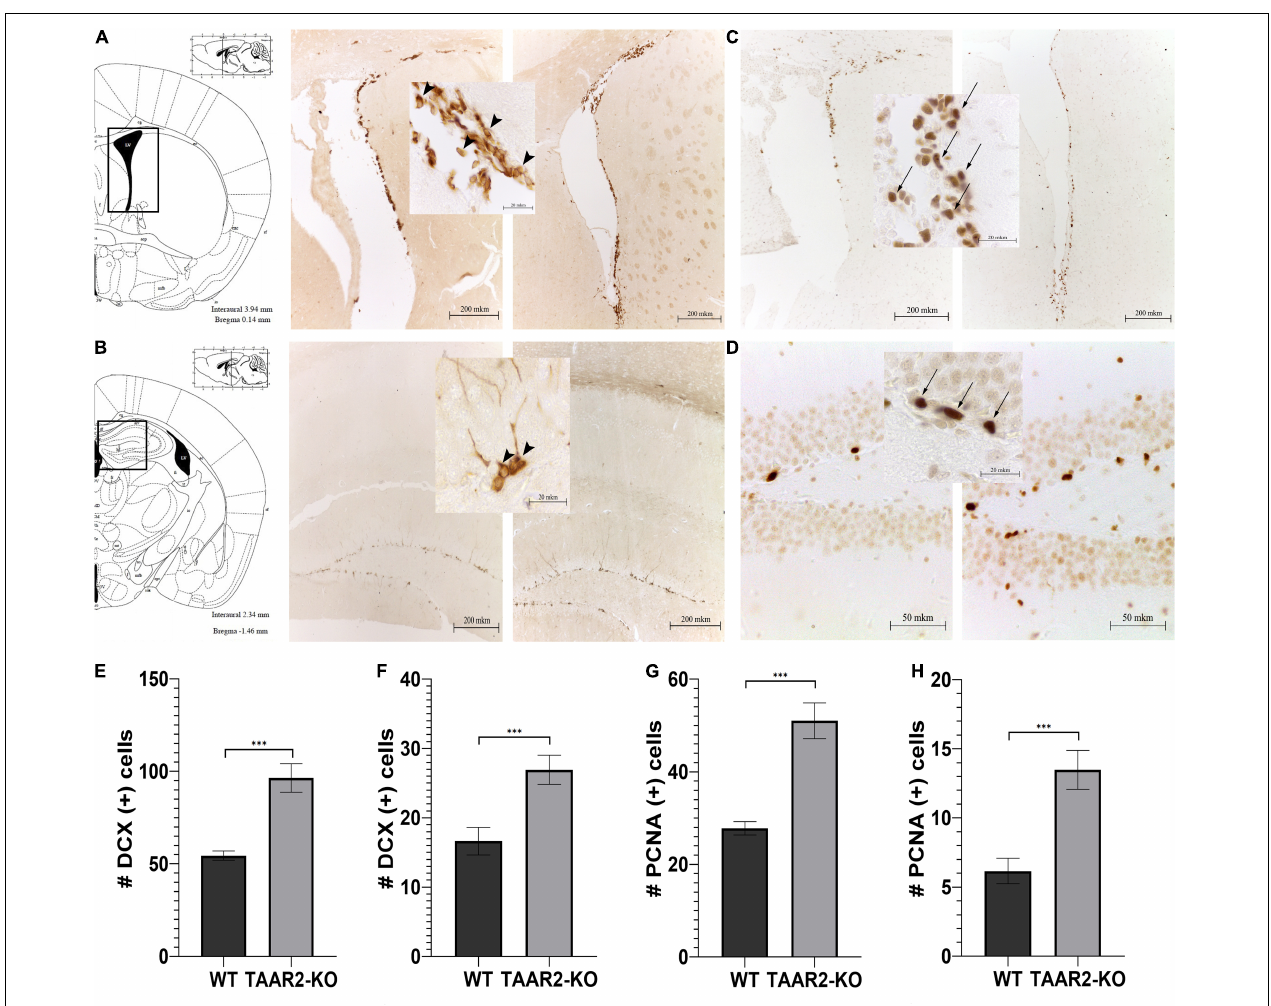
FIGURE 7 | | TAAR2-KO mice have an increased number of neuroblast-like and proliferating cells in subventricular (SVZ) and subgranular (SGZ) zones in comparison to WT animals. (A,B) Representative micrographs of doublecortin (DCX)-positive cells in mentioned brain structures of WT (left) and TAAR2-KO (right) mice; (C,D) representative micrographs of proliferating cell nuclear antigen (PCNA)-positive cells in mentioned brain structures of WT (left) and TAAR2-KO (right) mice; (E,F) the number of DCX-positive cells in SVZ and SGZ of WT and TAAR2-KO mice; (G,H) number of PCNA-positive cells in SVZ and SGZ of WT and TAAR2-KO mice. n = 5; *** p < 0.001 by t -test. Arrowheads indicate DCX-positive cells, while arrows indicate PCNA-positive